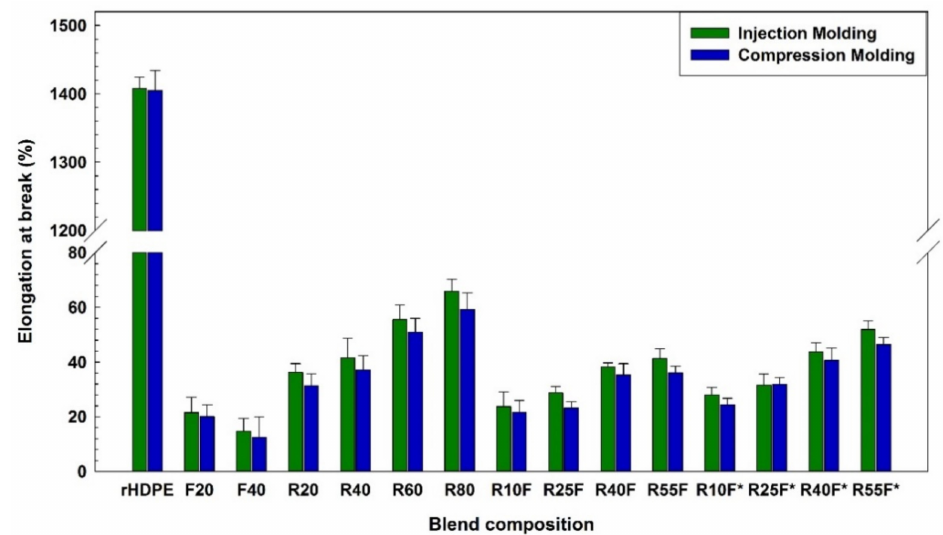
Figure 6. Elongation at break of the composites (see Table 1 for definition).